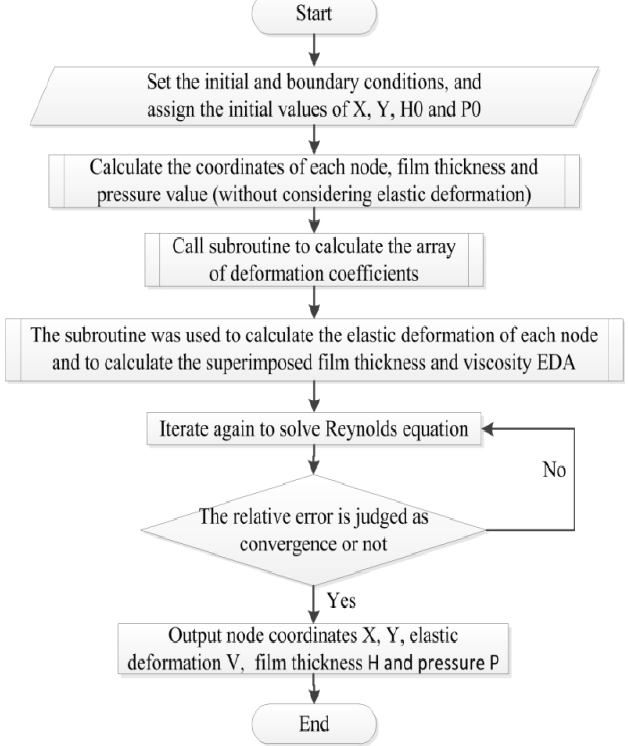
Figure 3. Isothermal EHL calculation block diagram.